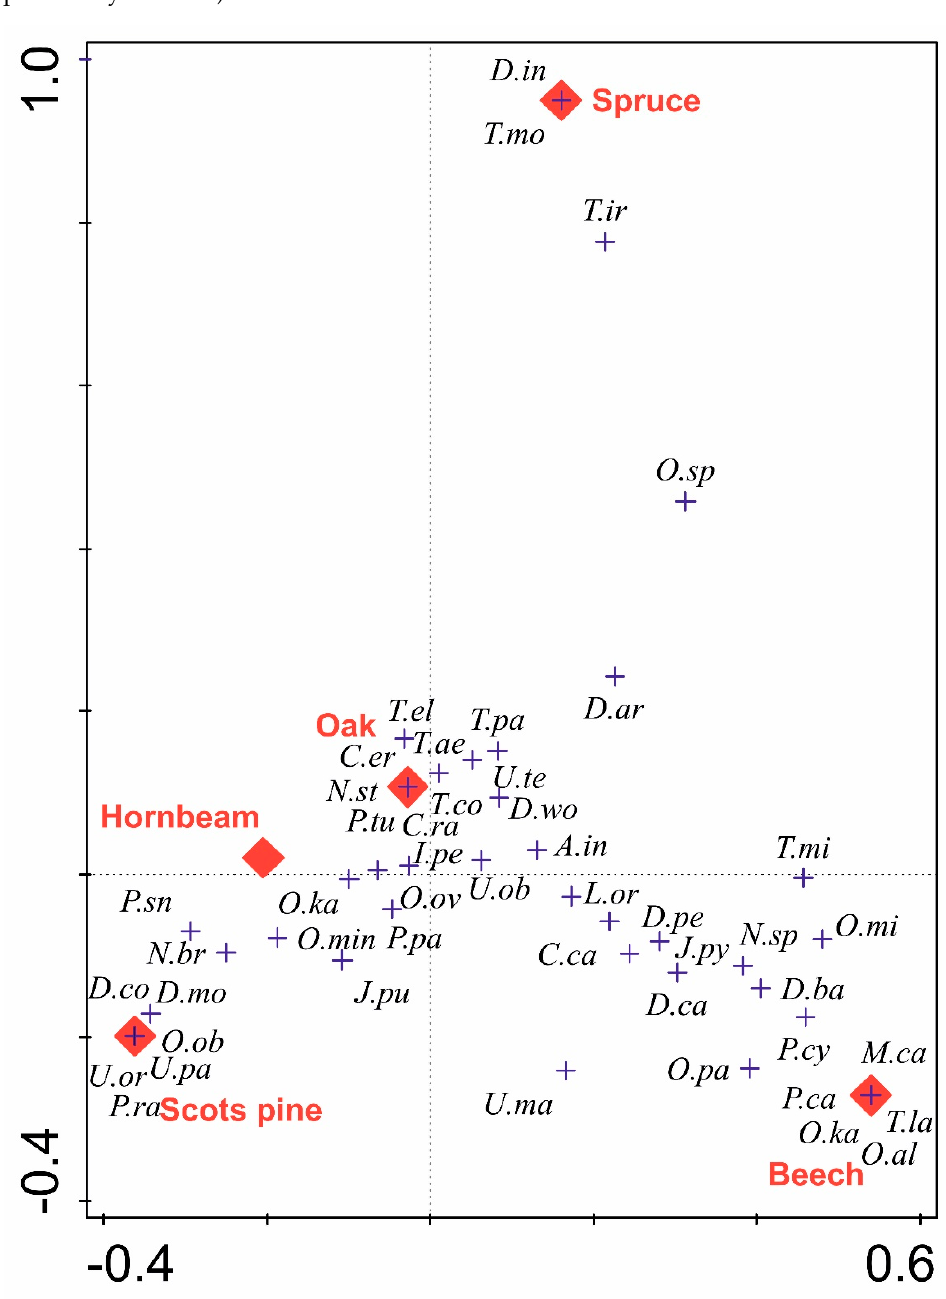
Figure 7. Canonical Correspondence Analysis (CCA) scatterplot showing the relationships between examined Uropodina mite communities from 114 beeches, 243 oaks, 69 hornbeams, 182 Scots pines, and 83 spruces on the first two axes. First and second axis explained 2.05% of variation. Abbreviations of species—in Section 2.